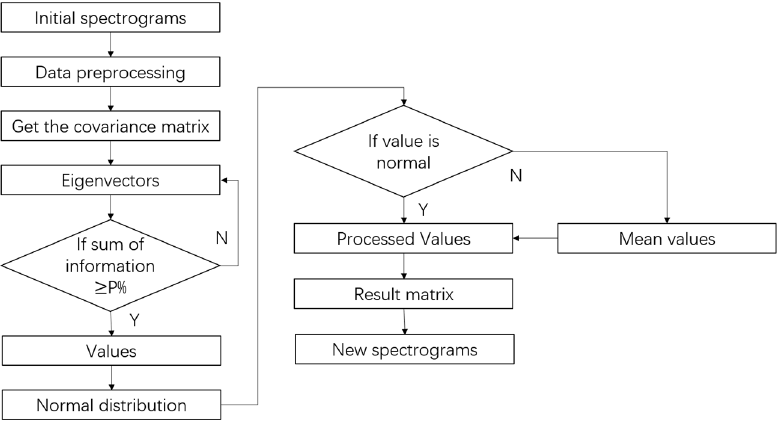
Figure 2. Data preprocessing process based on PCA.